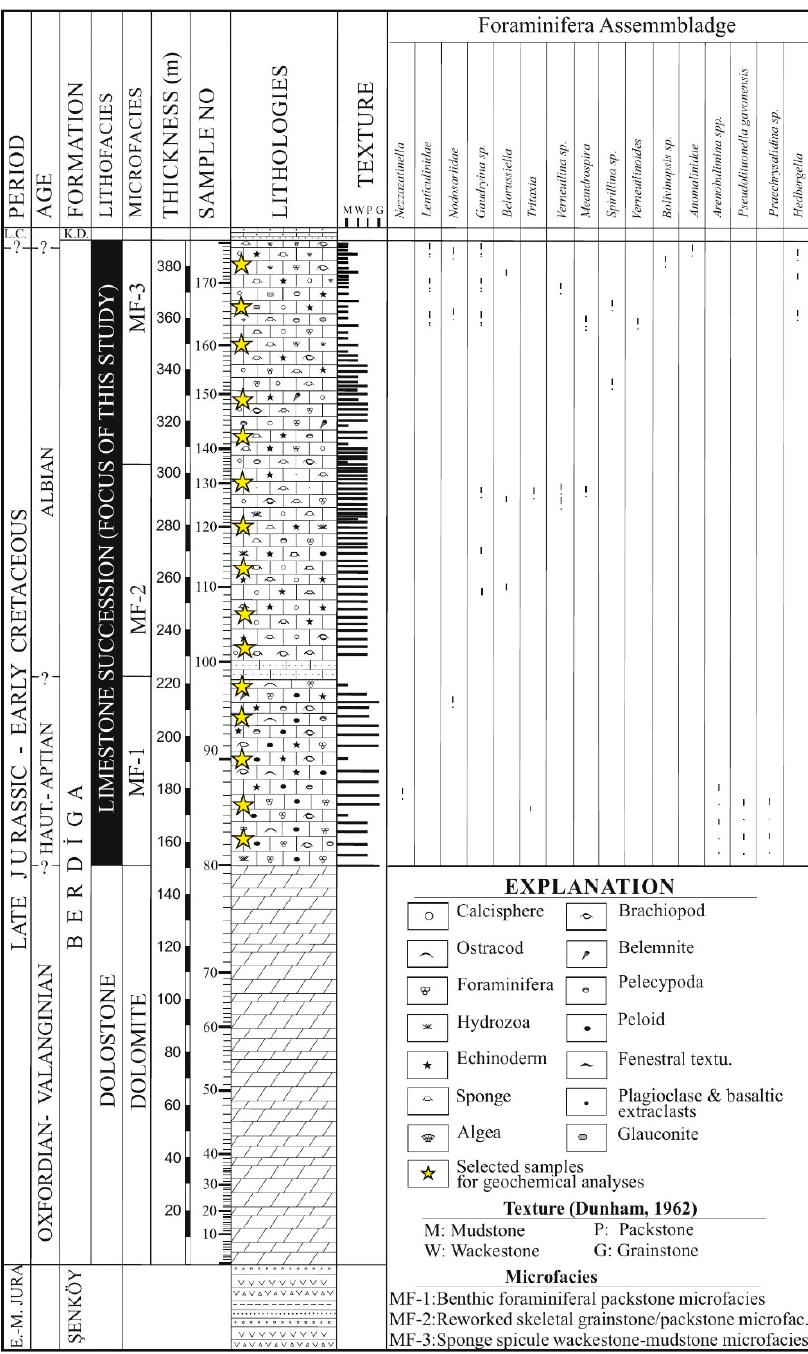
Figure 2. Stratigraphy, lithofacies and foraminifera distribution in the Berdiga Formation of the Mescitli (Gümü ş hane, NE Turkey) [31,38].